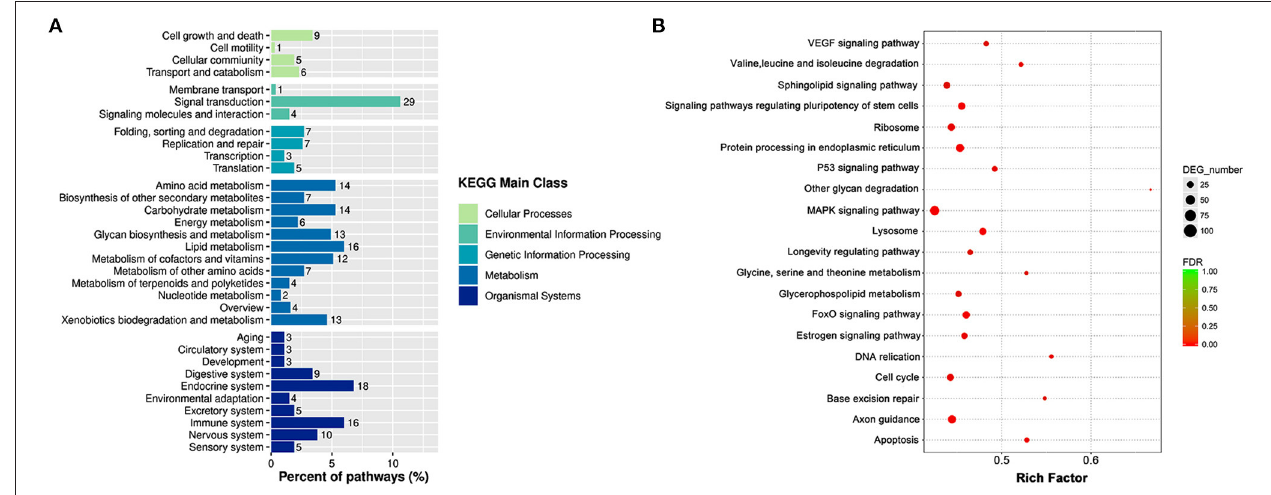
FIGURE 6 | The KEGG enrichment analyses of DEGs. (A) Histogram of KEGG pathways based on the enrichment classification. (B) Scatter diagram of signal transduction pathways of KEGG.